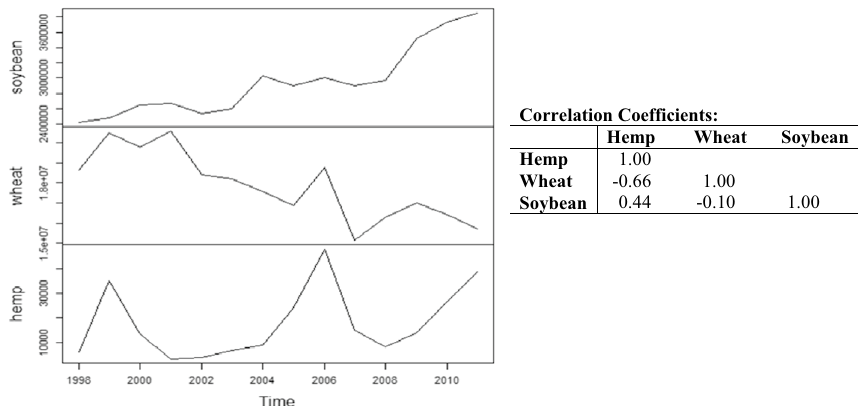
Table 2 Unit-root test and cointegration test of selected first-differenced time series variables